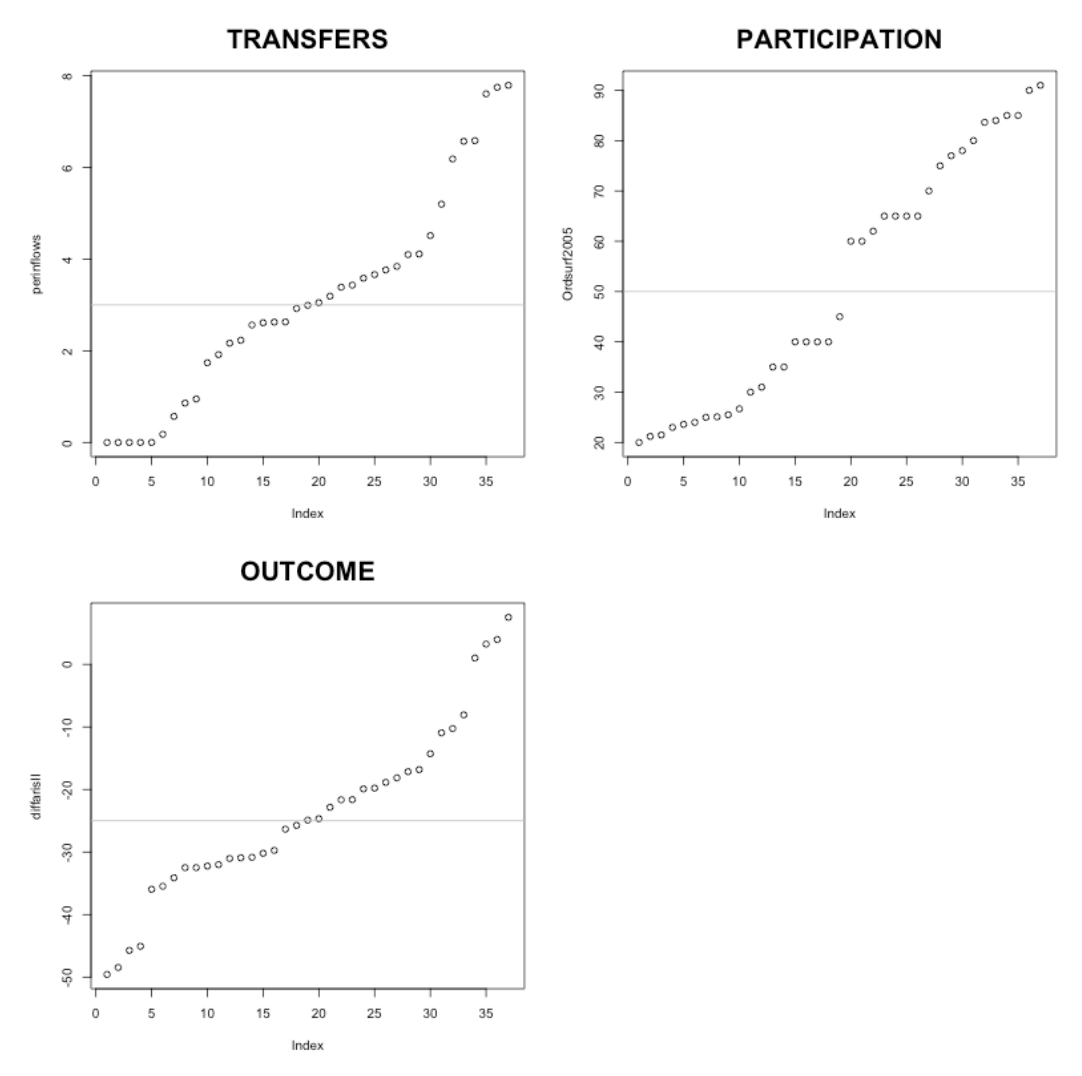
Figure A2.1 – Calibration of non-binary